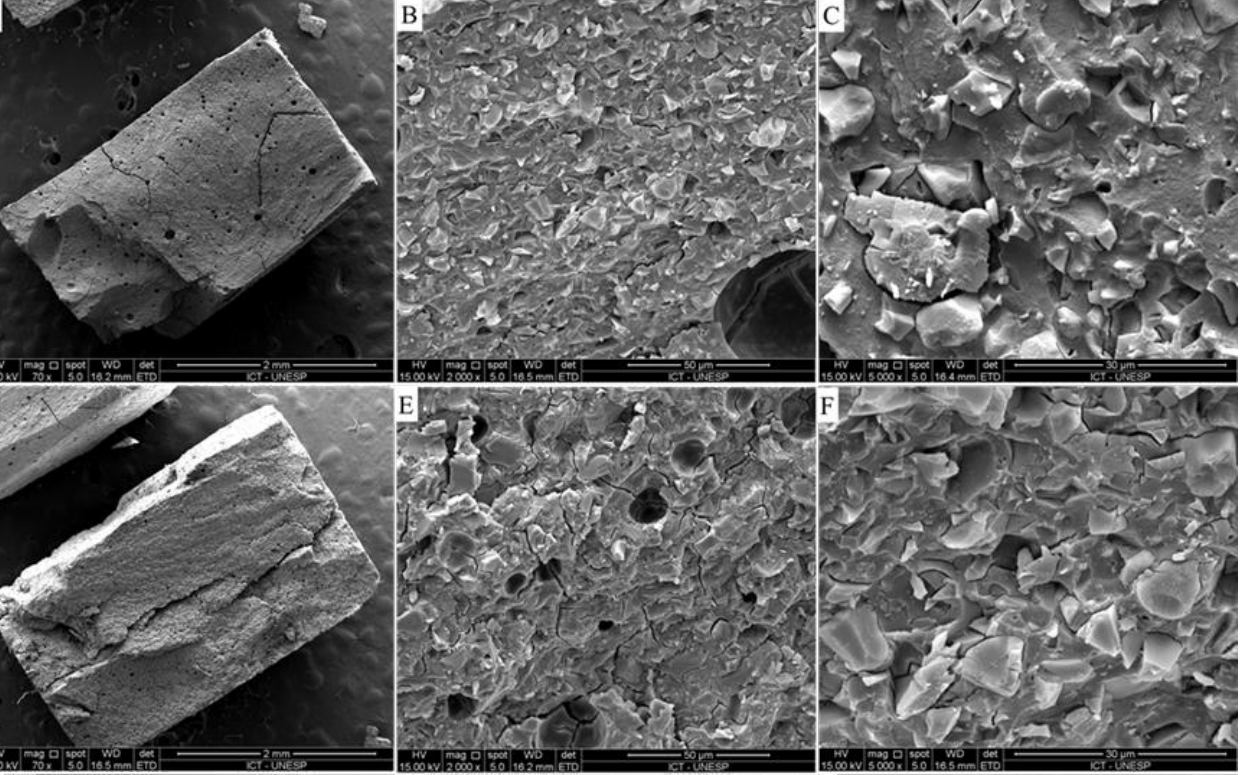
Figure 2. Scanning electron microscopy (SEM) of different specimens after the compressive strength test. ( A – C ) High- viscosity glass ionomer cement without MWCNT incorporation at 70, 1000 and 5000× magnification; ( D – F ) high-viscosity glass ionomer cement with MWCNT incorporation at 70, 1000 and 5000× magnification; ( G – I ) conventional glass ionomer cement without MWCNT incorporation at 70, 1000 and 5000× magnification; and ( J – L ) conventional glass ionomer cement with MWCNT incorporation at 70, 1000 and 5000× magnification. Yellow arrows indicate the presence of small cracks between the GIC particles. 4. Discussion The present study aimed to evaluate the effect of incorporating multi-walled carbon nanotubes (MWCNTs) into GICs with different viscosities through the evaluation of the compressive and tensile strengths. The results show that the mechanical properties were affected by the MWCNT incorporation, thus rejecting the null hypothesis.